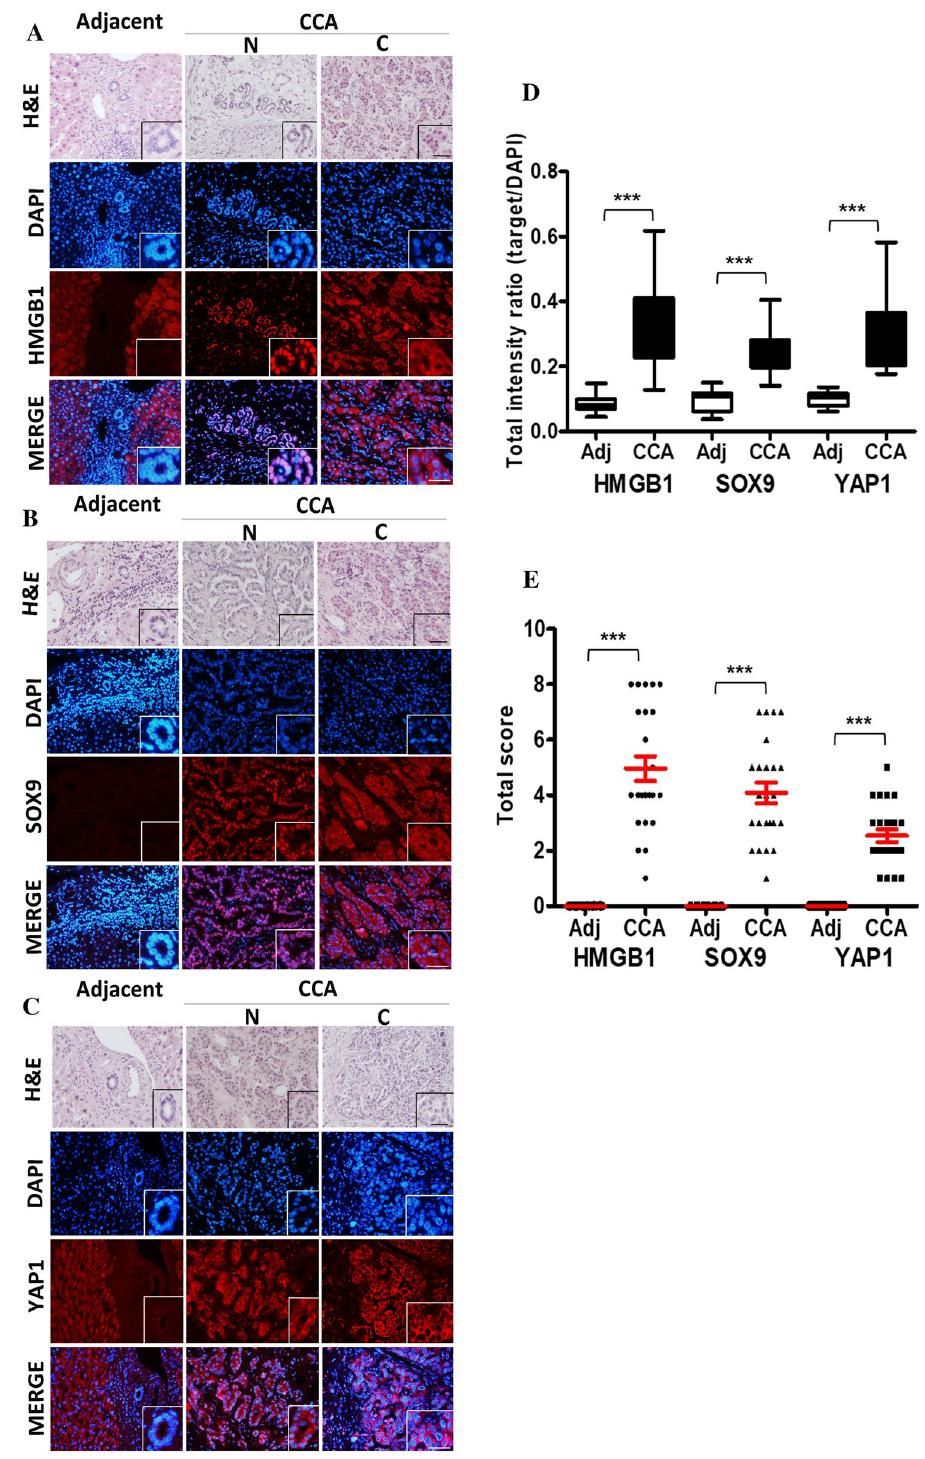
Fig. 2 Hematoxylin and eosin (H&E) and immunofluores- cence (IF) staining of human Clonorchis sinensis -infested cholangiocarcinoma (CS-CCA) and the adjacent normal tissues (bile duct cells) with three potential markers including high mobility group box 1 (HMGB1) ( A ), Sry-related high mobility group box 9 (SOX9) ( B ), and Yes-associated protein 1 (YAP1) ( C ). Typical images of nuclear (N) and cytoplasmic (C) localizations of CCA. The IF intensity ratio between target and DAPI ( D ). IF score of total cellular staining in CS-CCA and the adjacent normal tissues ( E